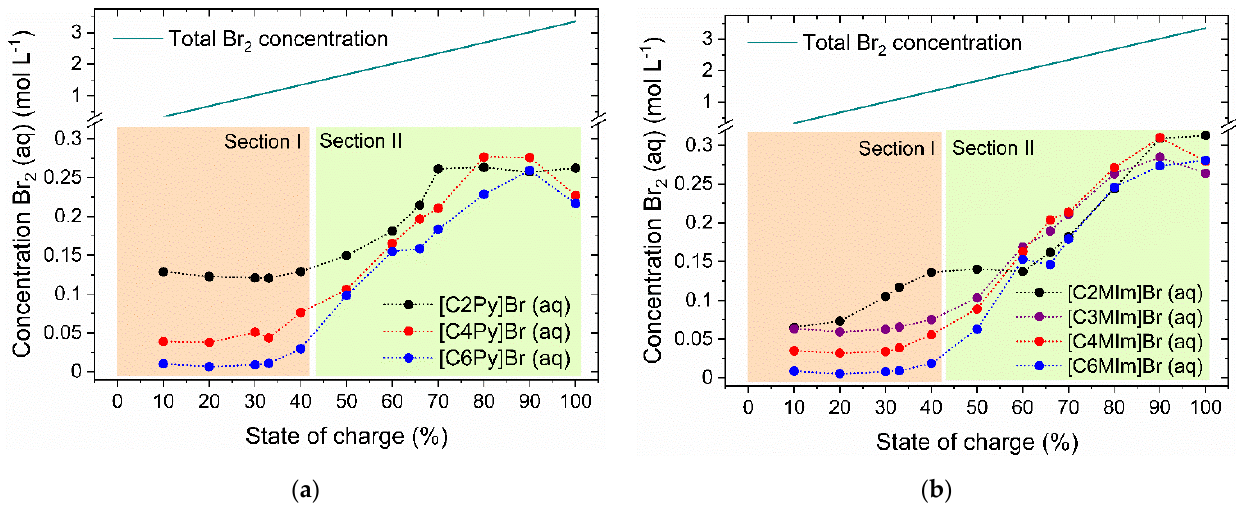
Figure 6. Concentrations of Br 2 solved in the form of polybromide ions in the aqueous electrolyte phase depending on the